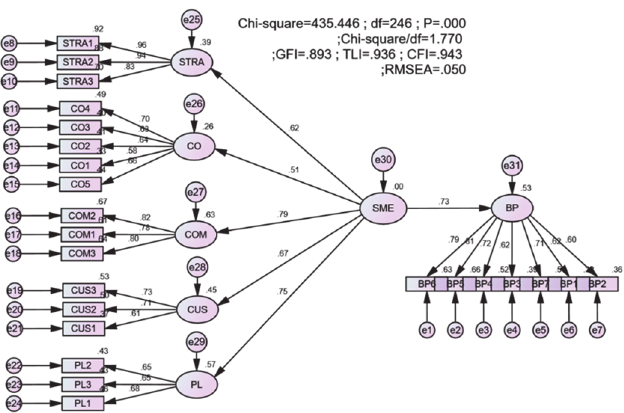
Fig. 4. Standardized Structural Equation Modeling